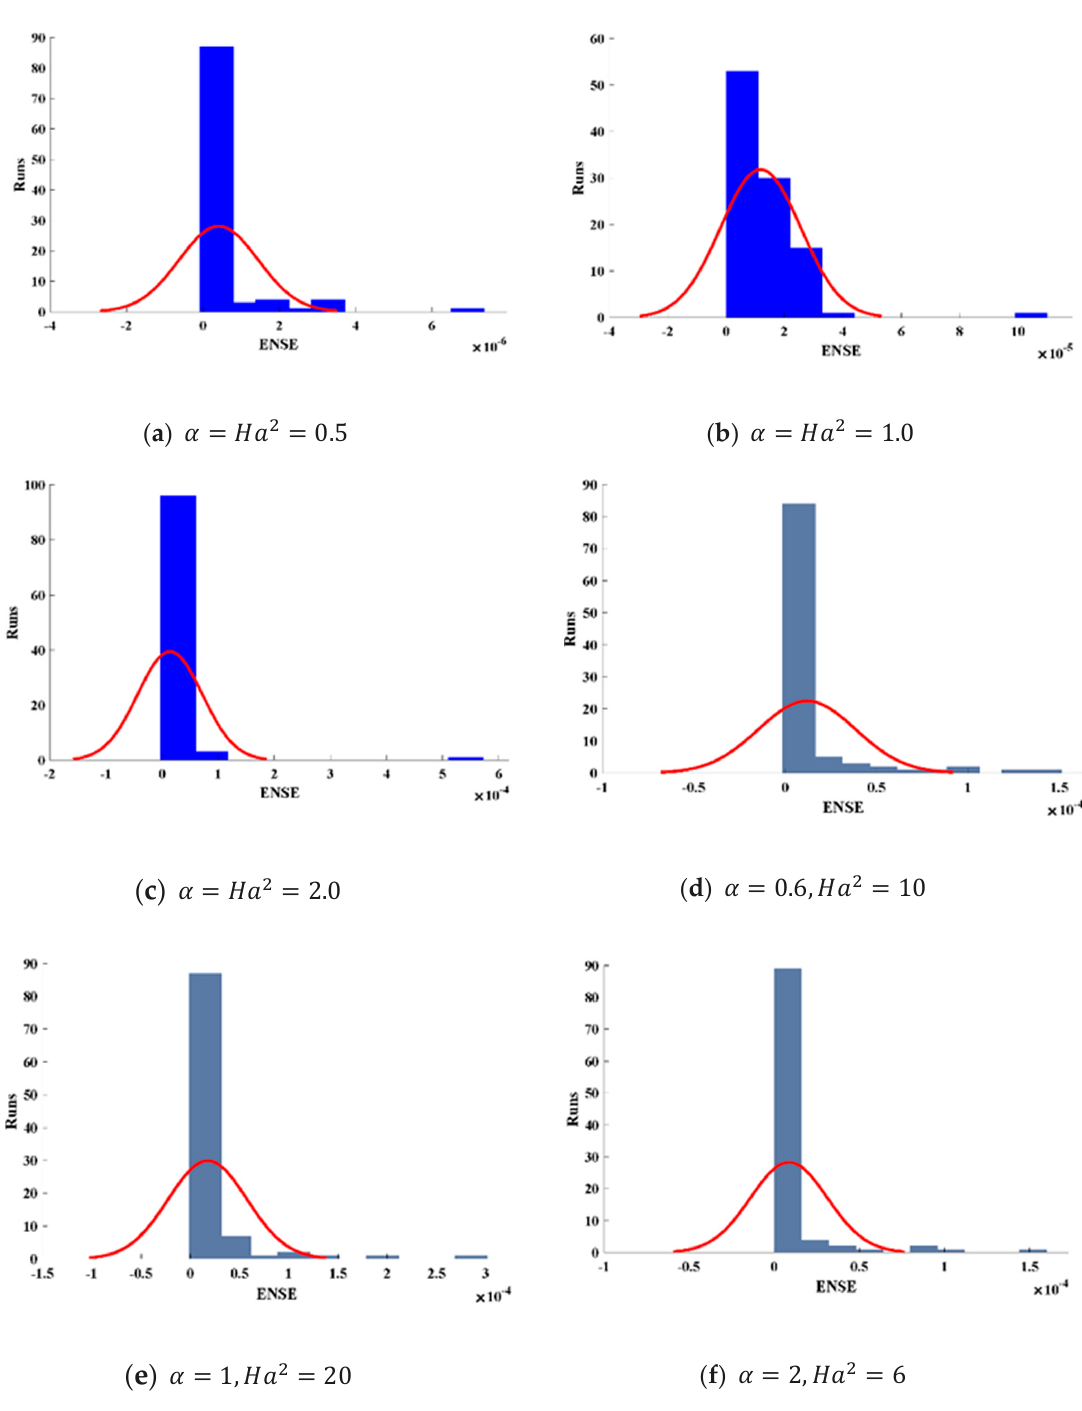
runs for ( a ) same and ( b ) different values of nonlinearity parameter and Hartmann electric number.